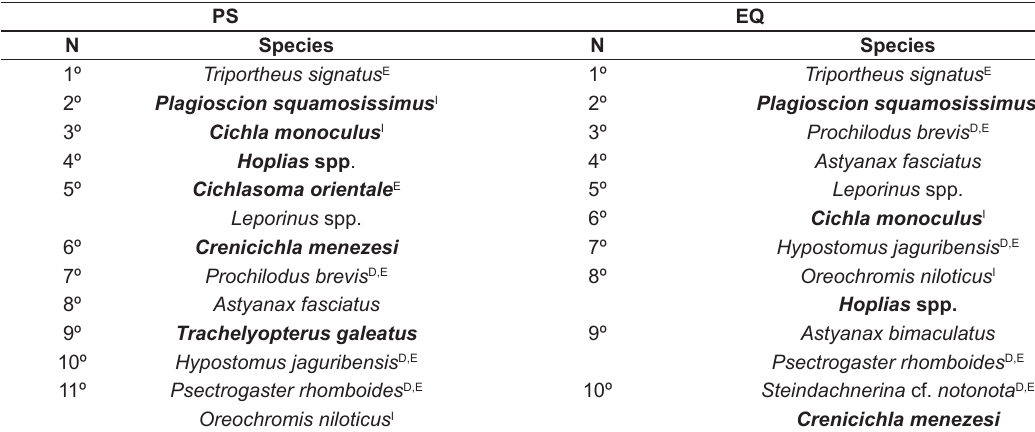
Table 3. Dominance (by abundance) of fish species in the reservoirs of Paulo Sarasate (PS) and Edson Queiroz (EQ). Bold: predators, D: detritivore, E: endemic to the Brazilian semiarid, I: introduced species. Among the captured spe- cies, 41.2% are endemic to the Brazilian semiarid region and 17.6% were introduced (Gurgel-Lourenço et al., 2013). PS